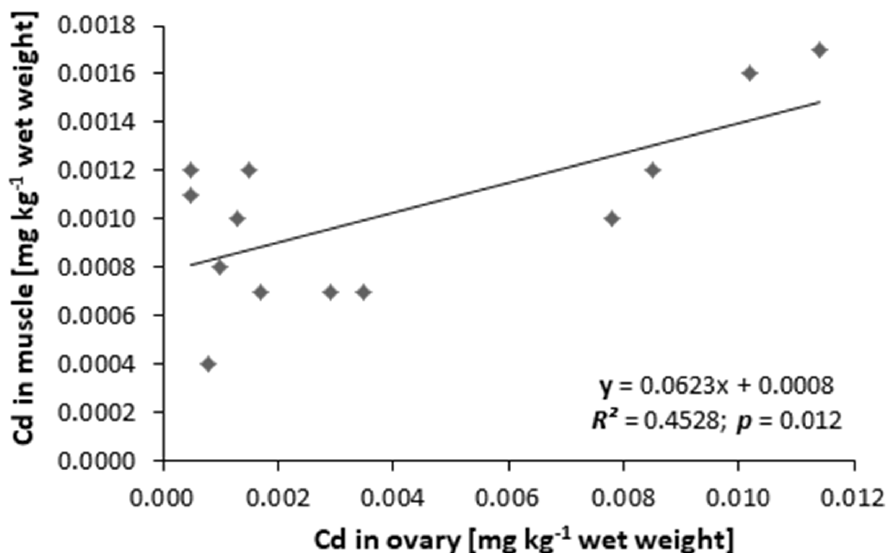
Figure 2. Relationship between cadmium content (mg kg − 1 wet weight) in muscles and its content in ovaries of silver female European eel Anguilla anguilla ( n = 13).